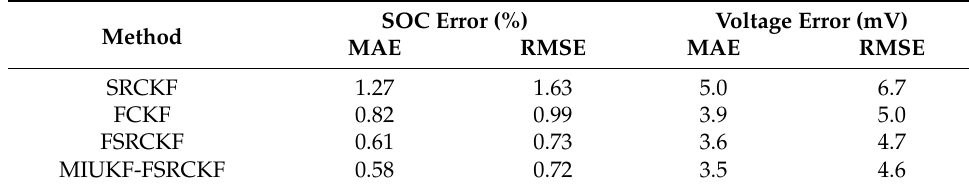
Figure 7. Comparison of the results of the four algorithms under BJDST: ( a ) SOC estimation result; ( b ) SOC error; ( c ) voltage estimation result; ( d ) voltage error. Table 5. SOC error and voltage error of each algorithm under the US06